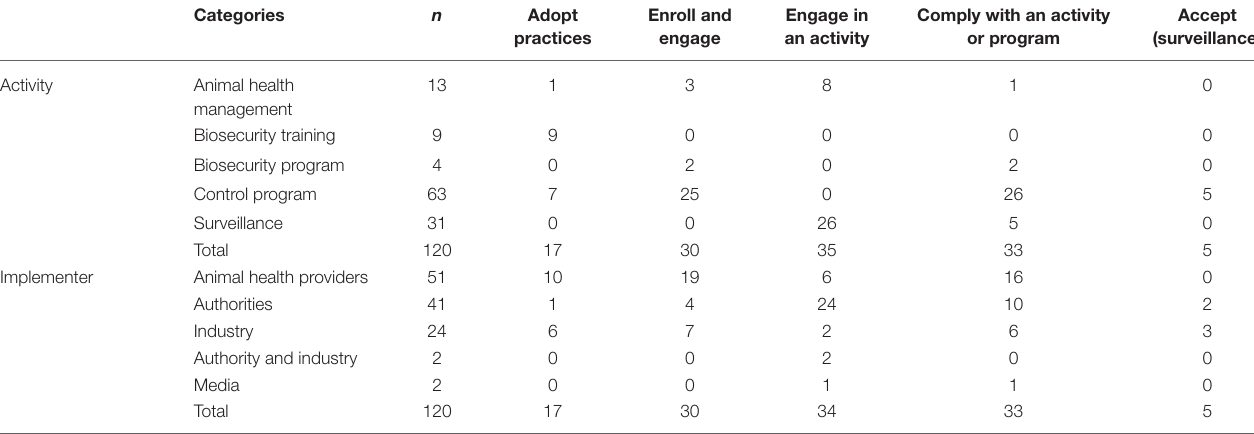
TABLE 2 | Number of strategies per type of activity and per implementer, in relation to the desired behavior they intend to promote.